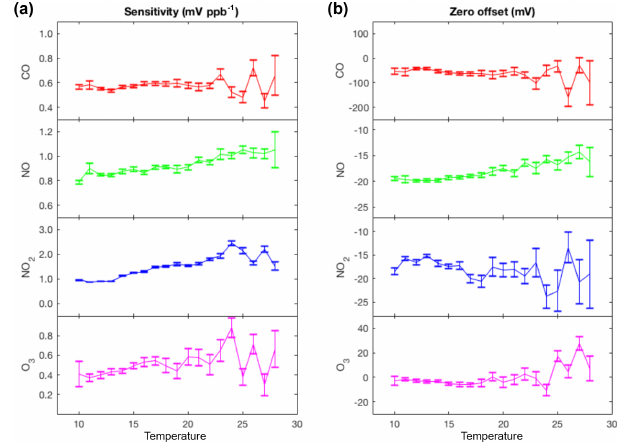
Figure 3. Representative temperature-dependent sensitivities (a) and zero offsets (b) of the Alphasense electrochemical sensors cal- culated by comparing hourly averaged measurements from Laney College BEACO 2 N node to measurements from a co-located refer- ence instrument during February to April